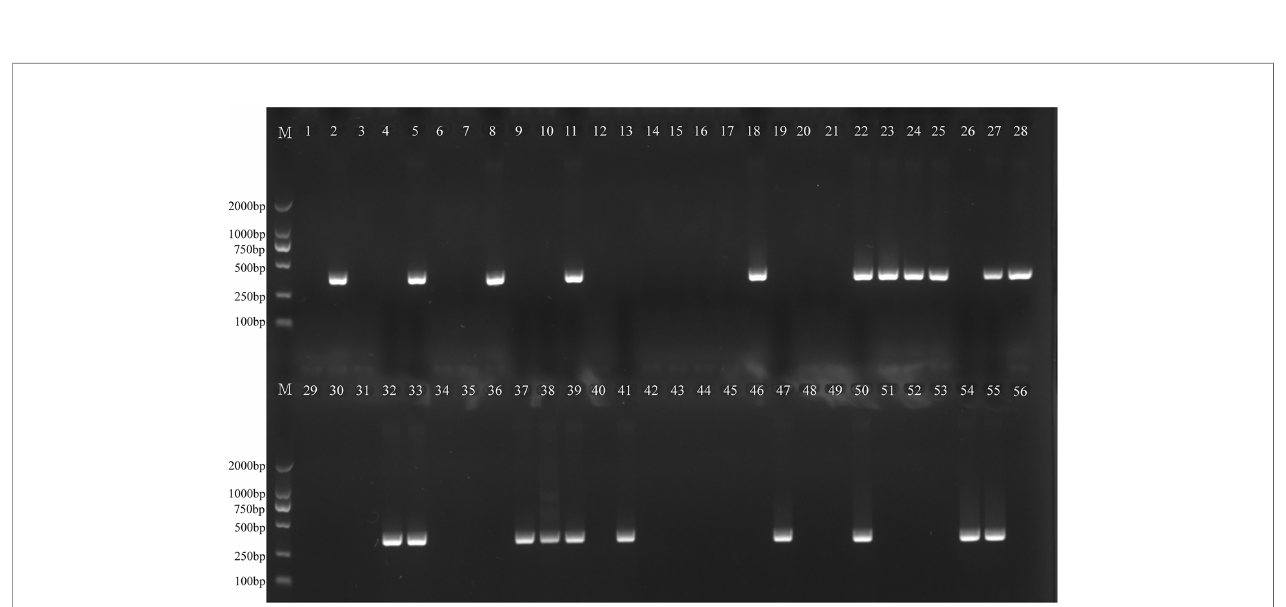
FIGURE 7 | PCR assay for detecting H. in fl uenzae in clinical samples. The numbers 2, 5, 8, 11, 18, 22 – 25, 27, 28, 32, 33, 37 – 39, 41, 47, 50, 54, 55 represented the positive results. Other numbers represented the negative results.